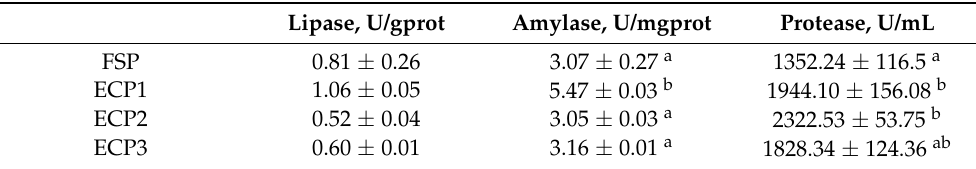
Table 7. Effect of fish soluble pulp and enzymatic chicken pulp in the intestinal digestive enzyme activities of L. vannamei